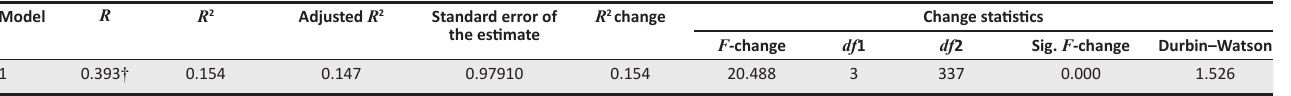
TABLE 1-A1: Model summary.